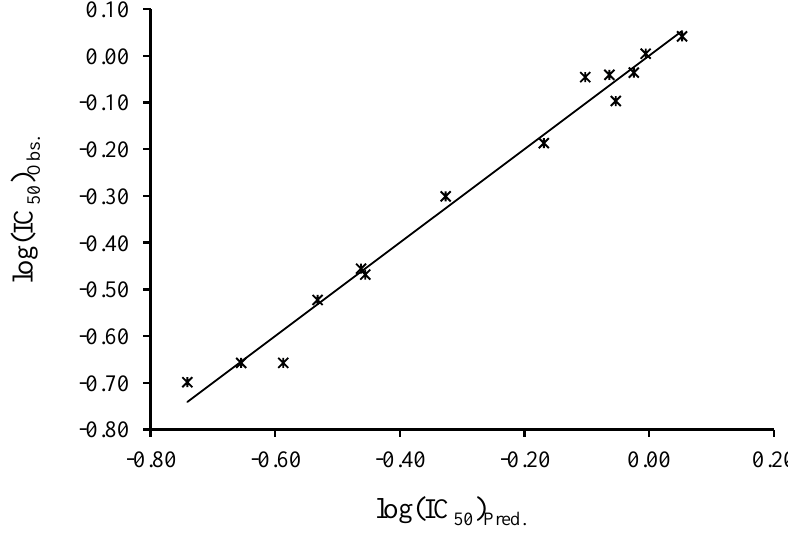
Figure 1. Multiple linear regression curve between the log(IC active Schiff bases.